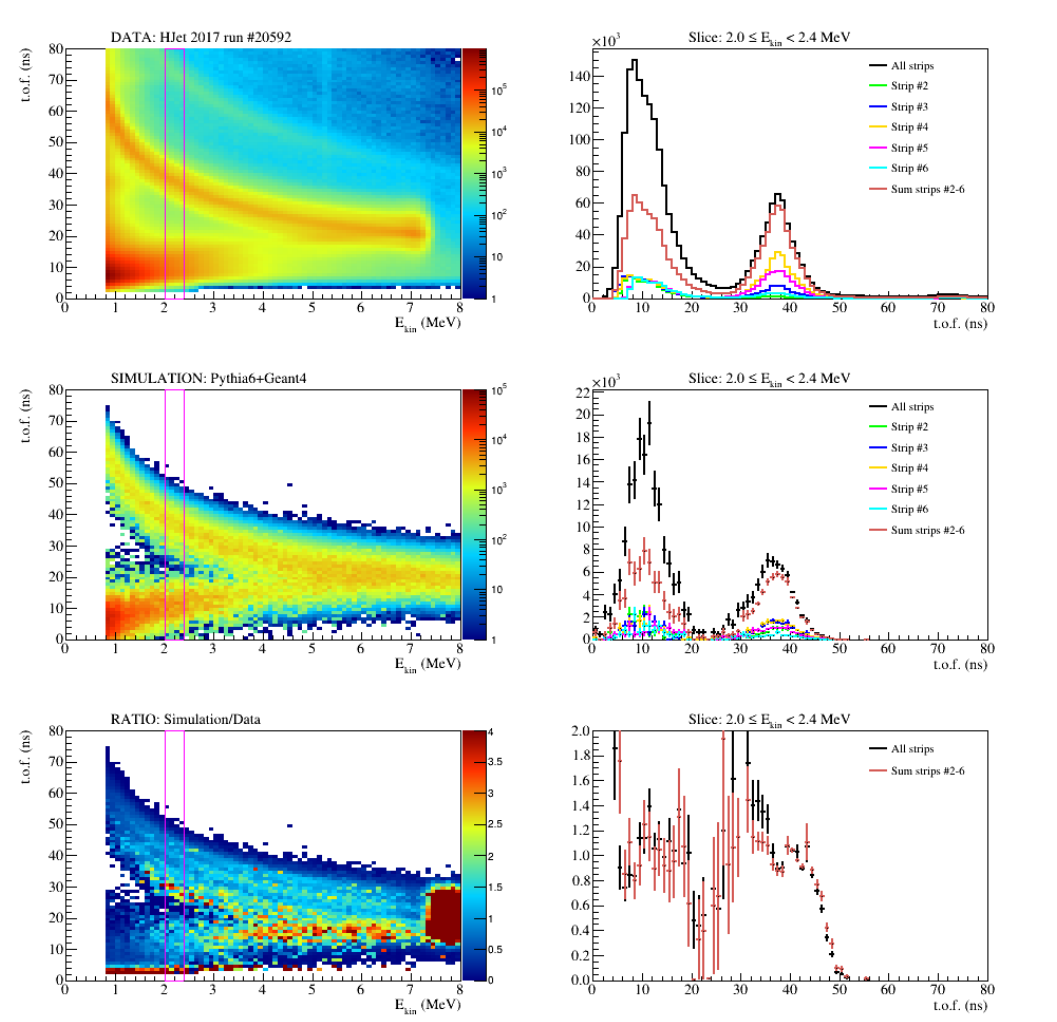
Figure 1: Data, simulation and their ratio for (left) the time of flight vs deposited energy of particles reaching the silicon detectors of the Hjet polarimeter and (right) the distribution of the time of flight of hits on the relevant silicon strips in the detec- tors, for a selected deposited energy range (from 2 to 2.4 MeV). In the first row, data from one run of 2017 is shown; in the second row, the results from simulations; in the third row, the ratio between data and